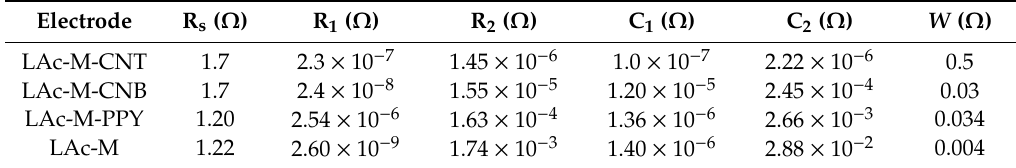
Table 3. Impedance data for the